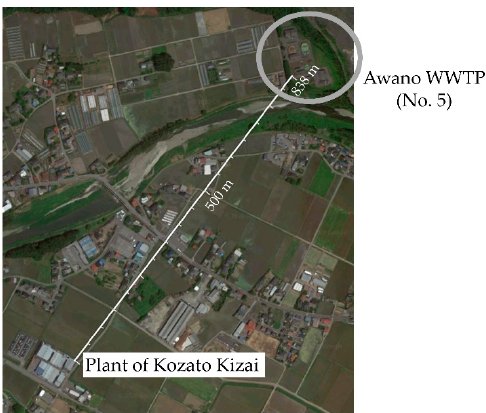
Table 3. Cost calculation parameters for each scenario.